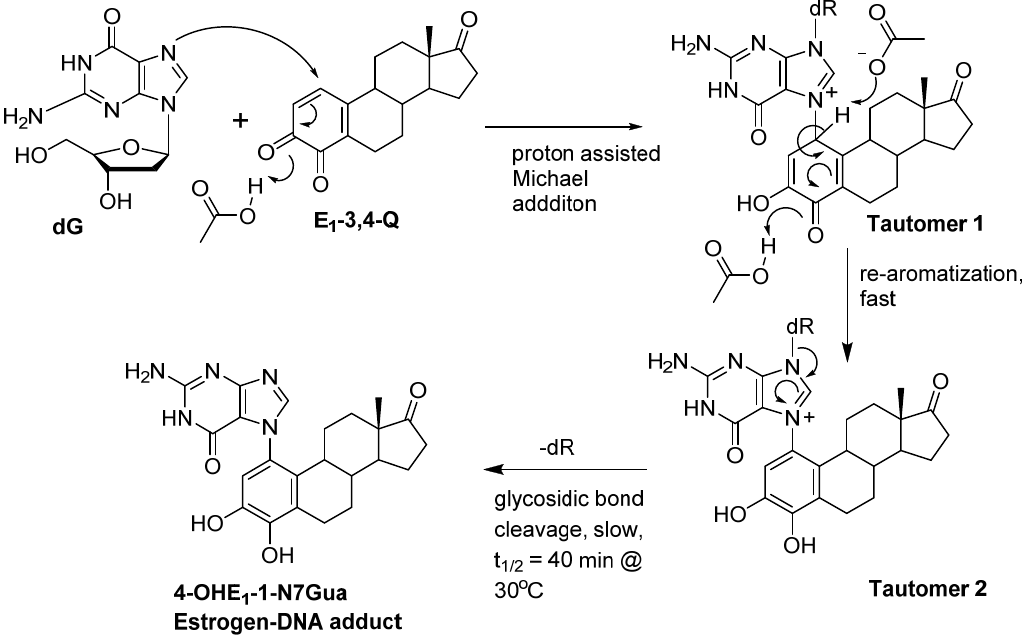
Figure 8. Revised mechanism of the reaction of E 1 -3,4-Q with